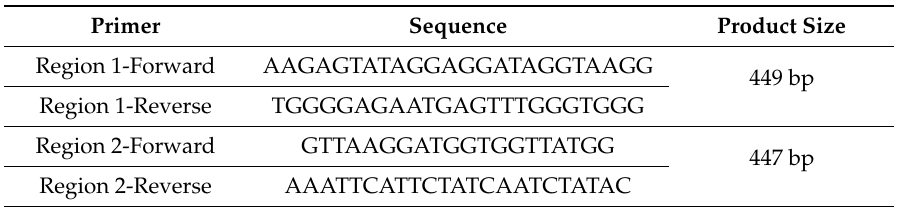
Table 1. List of Primers.